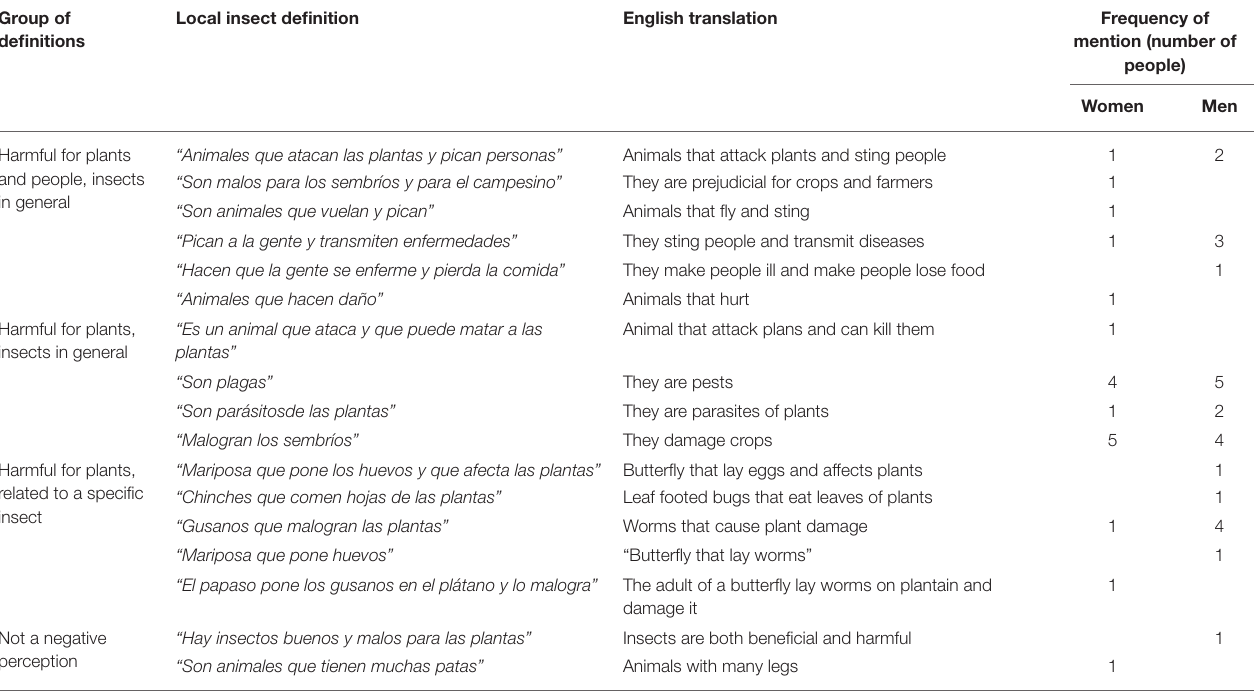
TABLE 1 | Frequency of farmers’ emic conceptualizations of